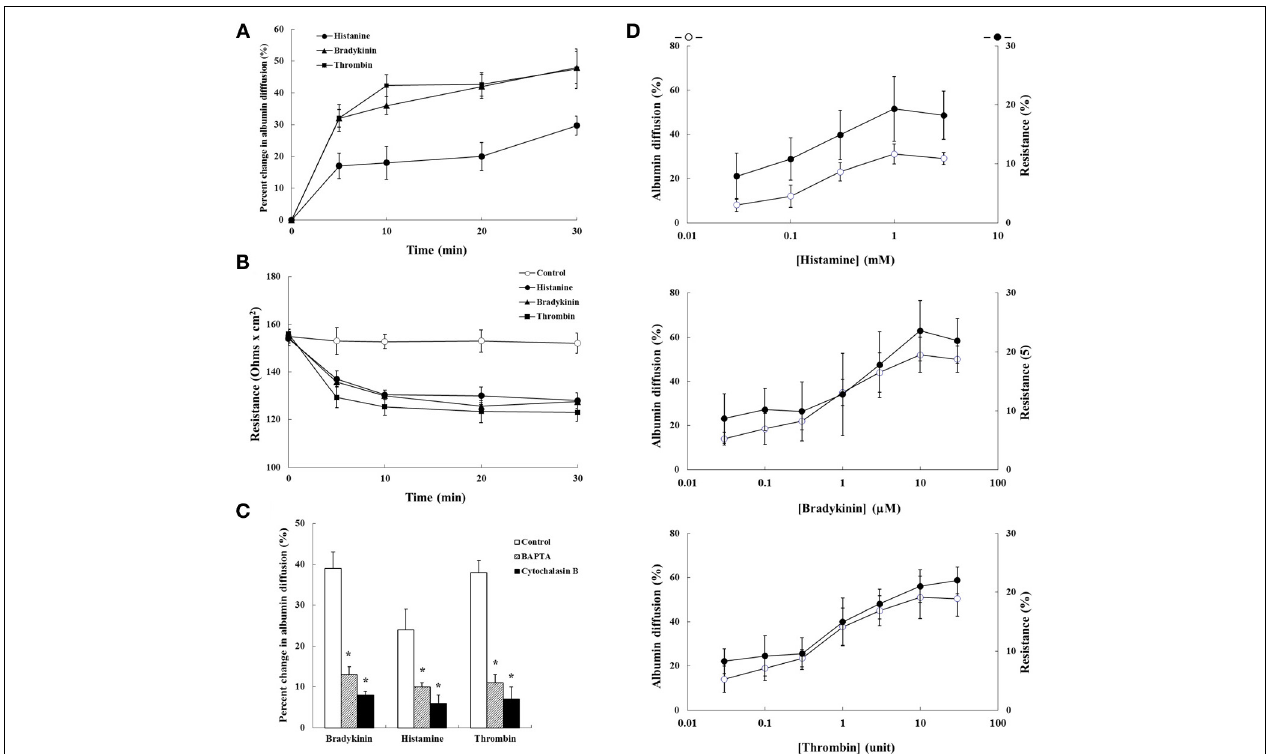
FIGURE 1 | The effects of bradykinin (10 µ M), histamine (1mM), and thrombin (10 U) on the permeability of mesothelial cell monolayers. (A) Time course of trypan blue-albumin diffusion across the mesothelial cell monolayers, (B) time course of transmesothelial electrical resistance of the mesothelial cell monolayers, and (C) effects of Ca 2 + chelation by BAPTA